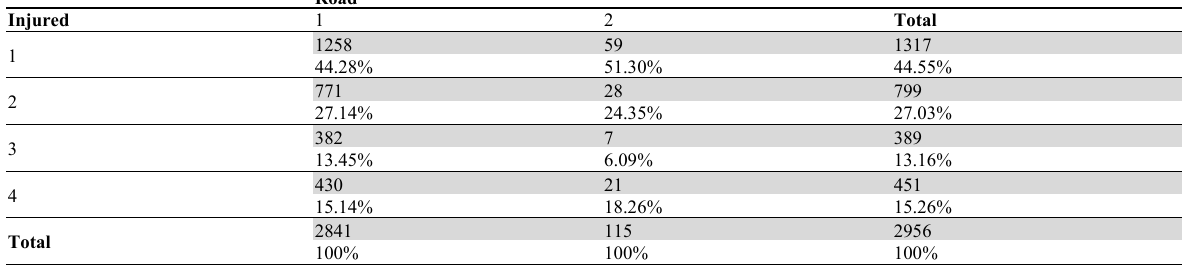
Number of cases between road administration and injured quantiles